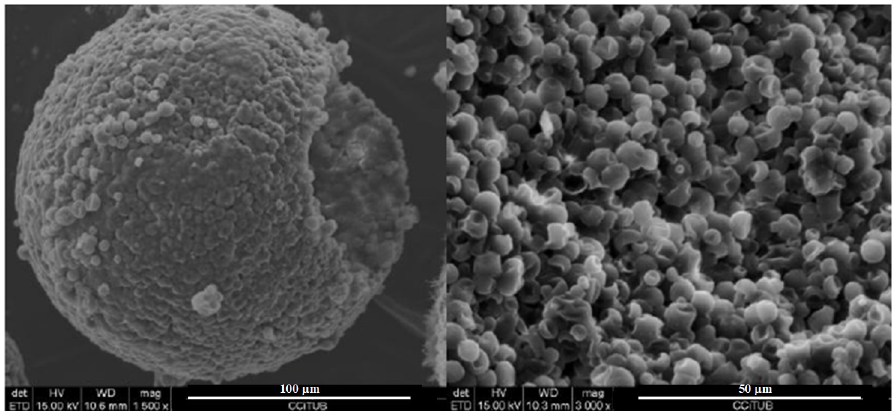
Figure 1. Scanning electron microscopy (SEM) micrographs of mPCM after six weeks in contact with 4 M NaOH.